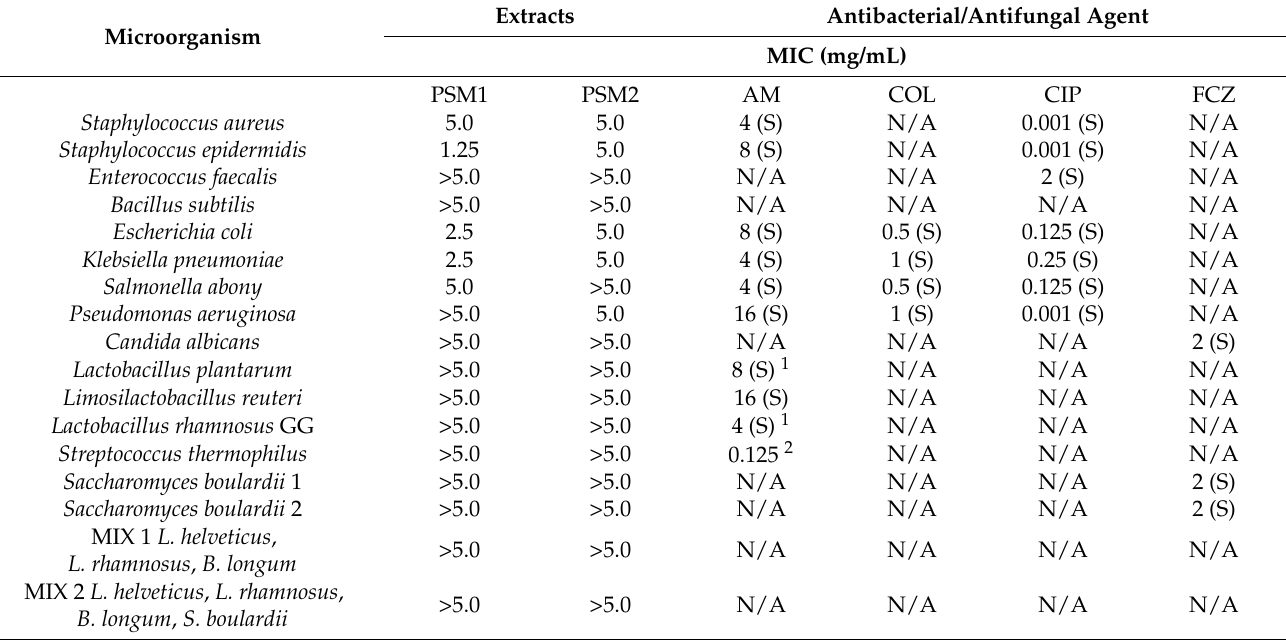
Table 4. Antimicrobial activity of blackthorn fruit methanol